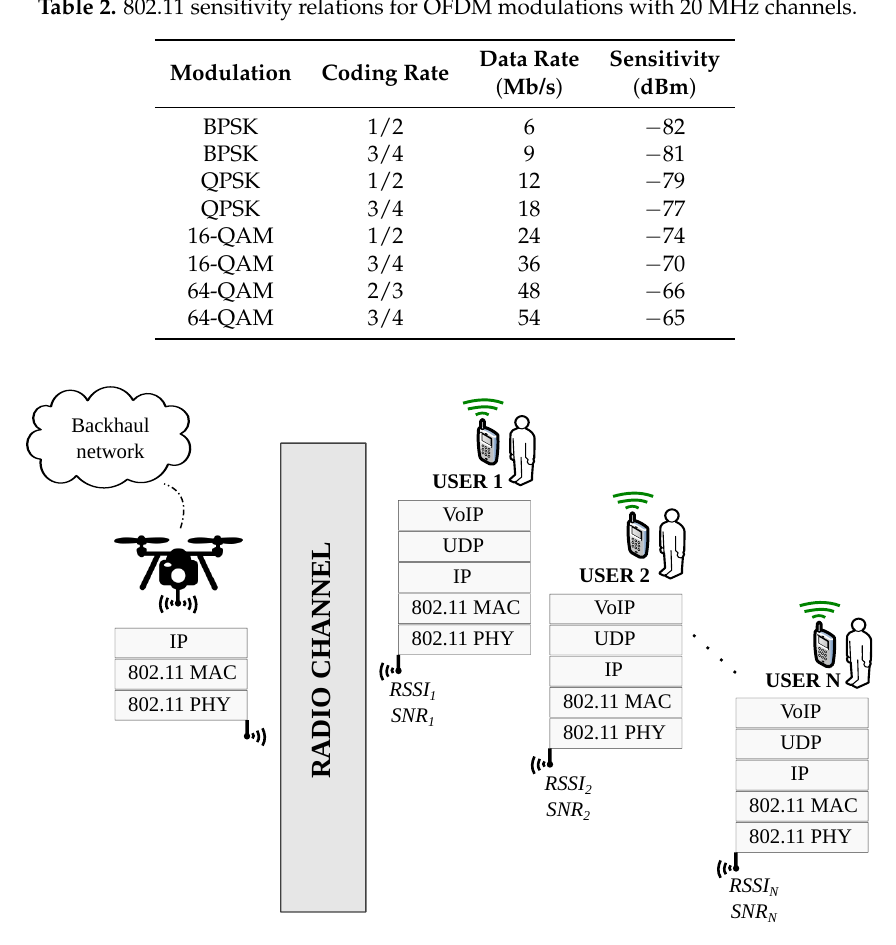
Table 2. 802.11 sensitivity relations for OFDM modulations with 20 MHz channels.